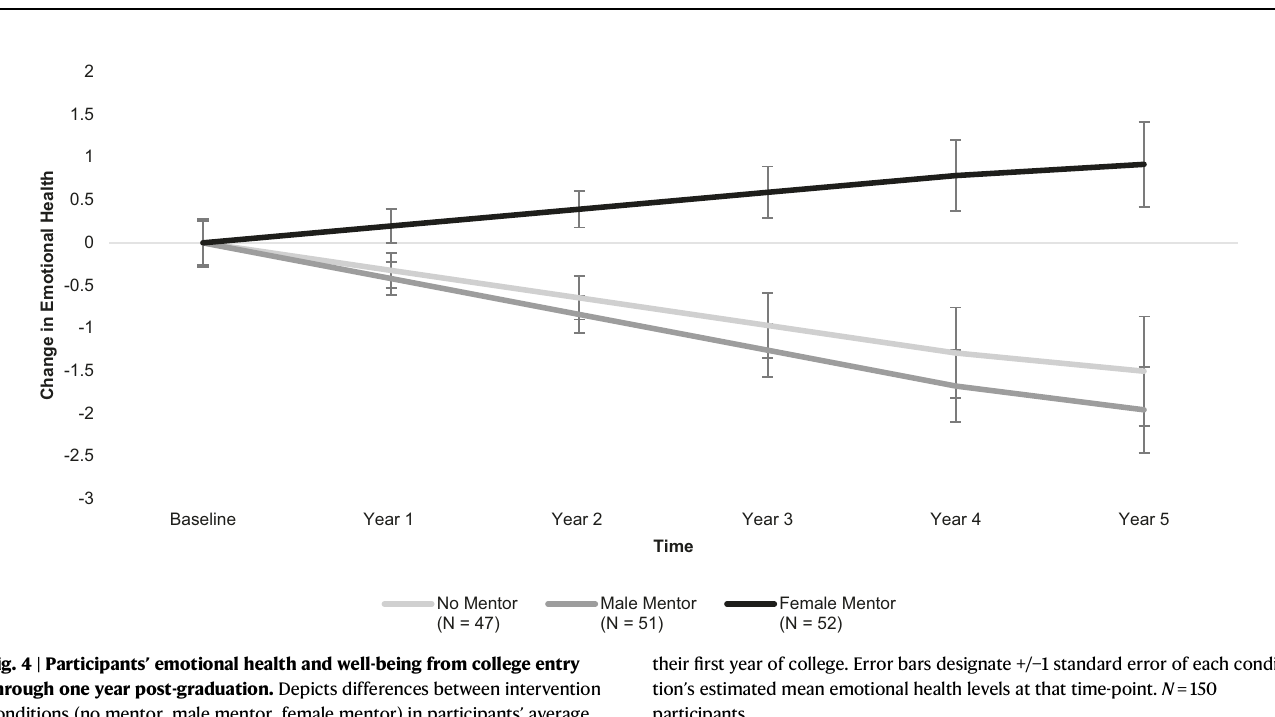
Fig. 4 | Participants ’ emotional health and well-being from college entry through one year post-graduation. Depicts differences between intervention conditions (no mentor, male mentor, female mentor) in participants ’ average change in emotional health over fi ve years, relative to their reported levels during